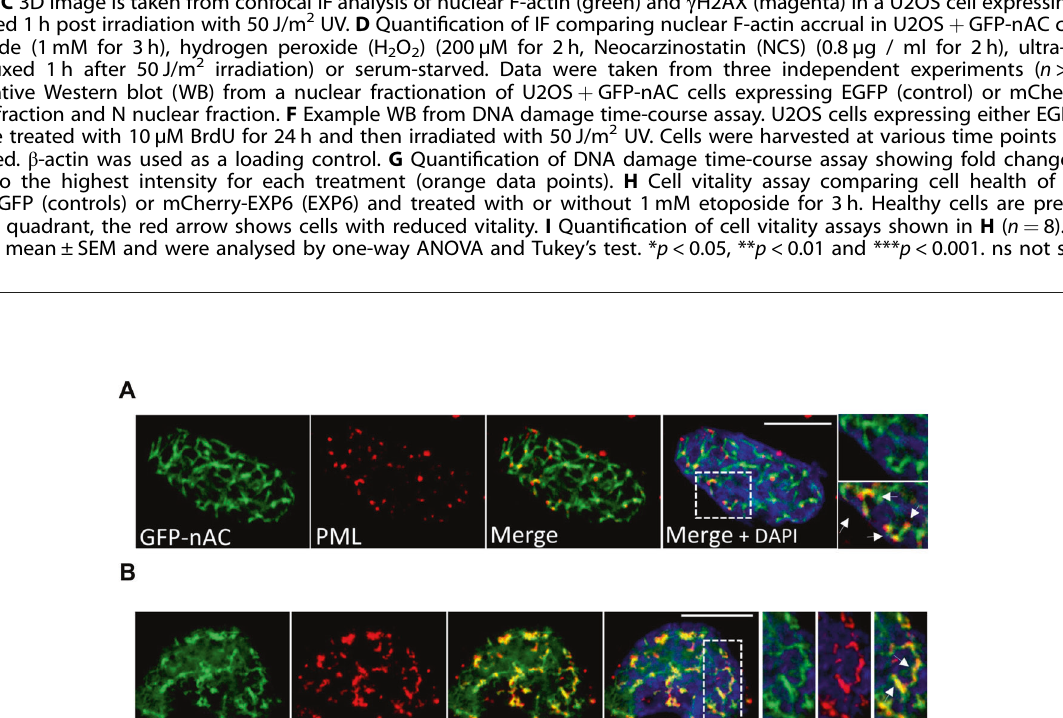
Fig. 2 PML NBs localise along nuclear actin fi laments. A Representative IF image of a U2OS + GFP-nAC cell showing actin (green) co-stained with PML (red). Colocalisation is evident by yellow staining (white arrows). B Additional example of nuclear actin and PML colocalization. The spreading of PML along F-actin is visible (white arrows). DNA is stained with DAPI (blue). Scale bars = 10 µm.